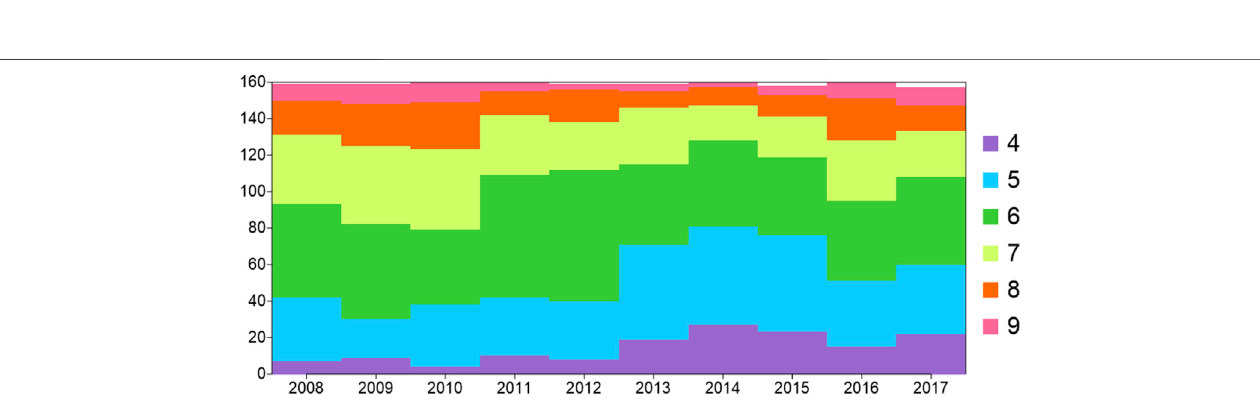
FIGURE 6 | Interannual variation characteristics of the total clustering numbers in different years. The x -axis represents time (year), and the y -axis represents the number of stations.